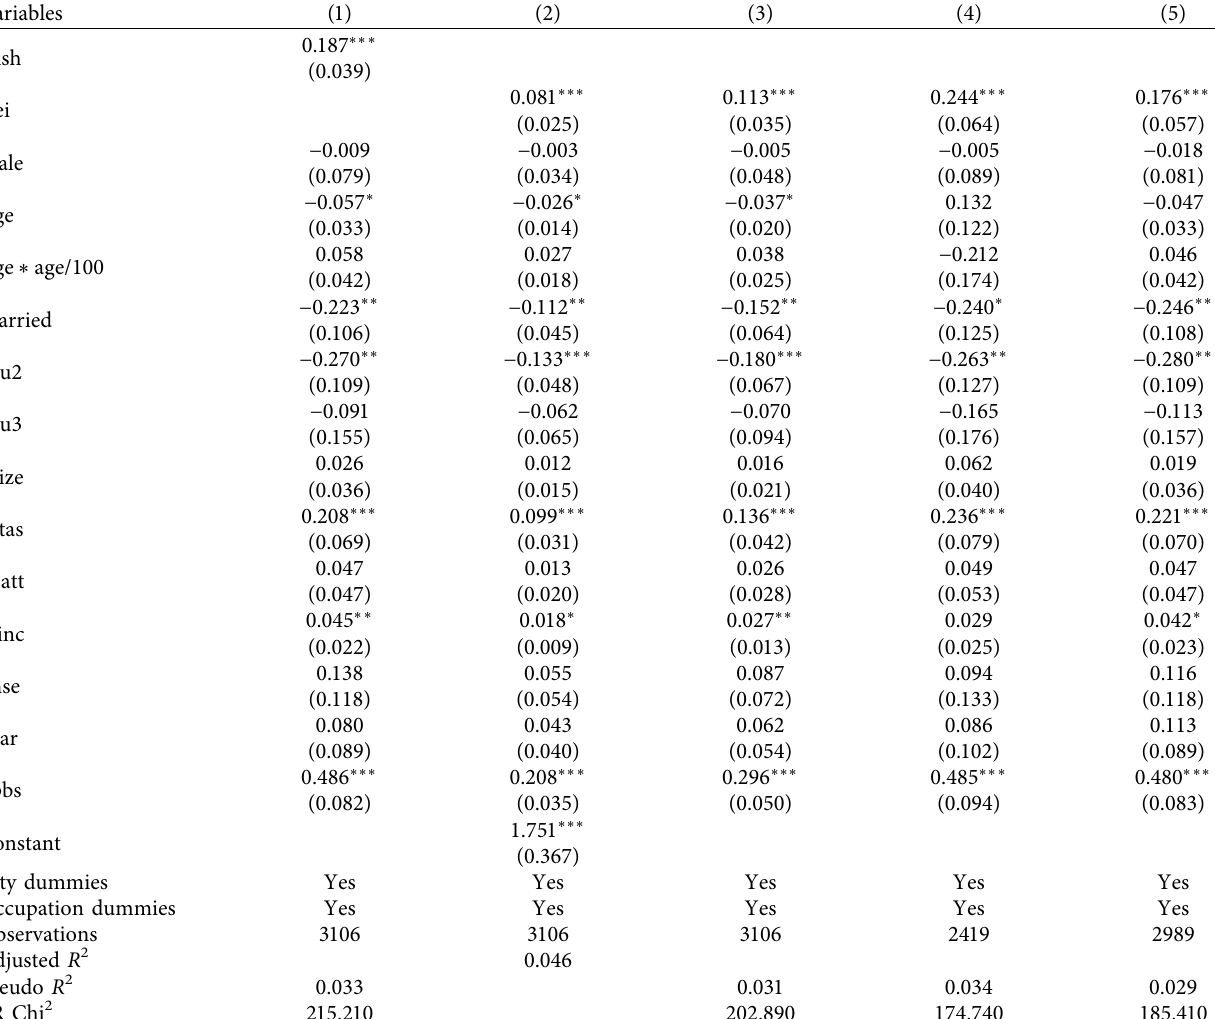
Table 8: Results of robustness